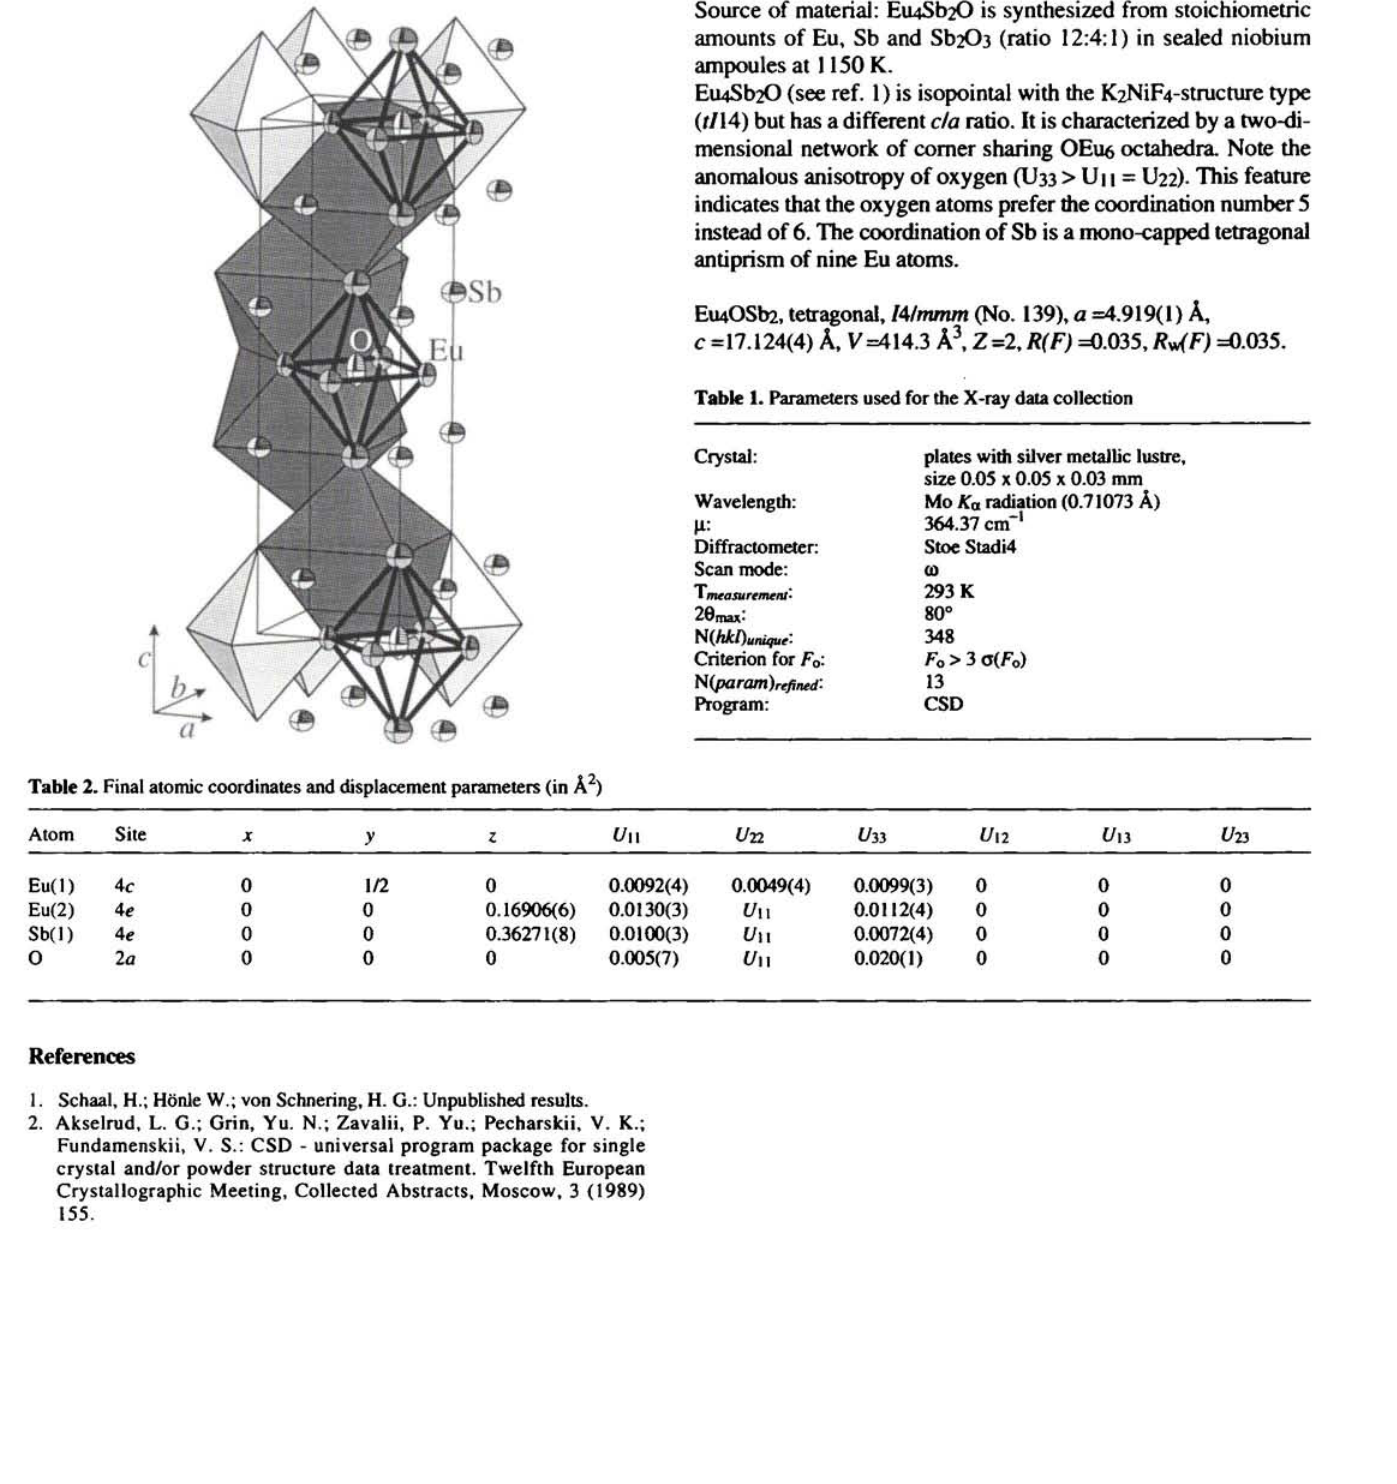
Table 2. Final atomic coordinates and displacement parameters (in Â^)